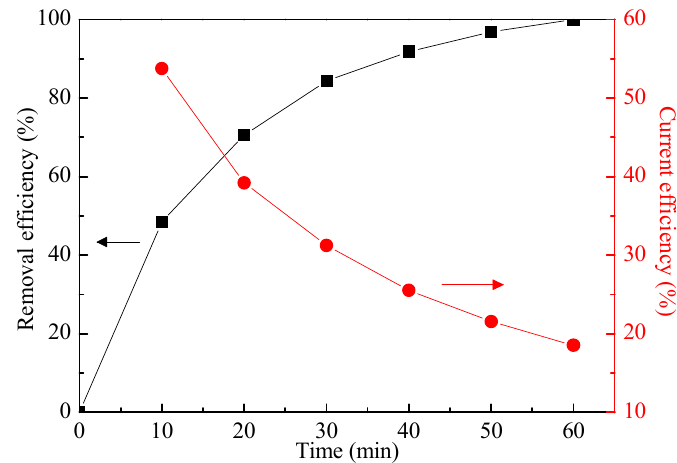
Figure 6. The ammonia removal and current efficiency during the electro-oxidation process. Initial pH value of 8.3, applied current density of 20 mA cm − 2 , NaCl concentration of 1.0 g L − 1 , and a flow of 300 mL min − 1 .